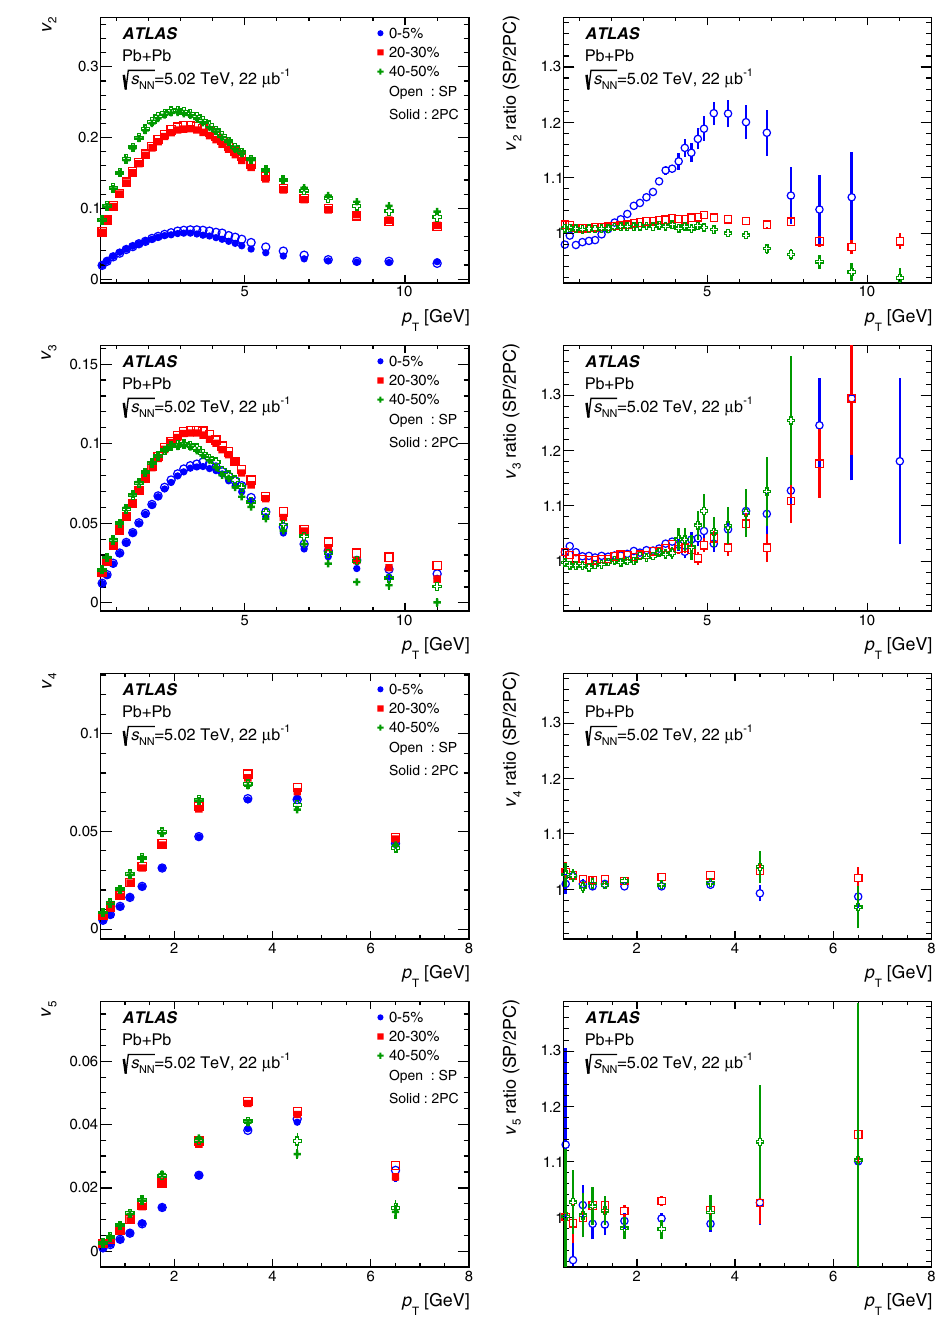
Fig. 8 Comparison of the v n obtained with 2PC and SP methods as a function of p T . Each panel shows the comparison for a different order harmonic. The comparisons are shown for three different centrality intervals: 0–5%, 20–30% and 40–50%. The vertical error bars indicate statistical uncertainties